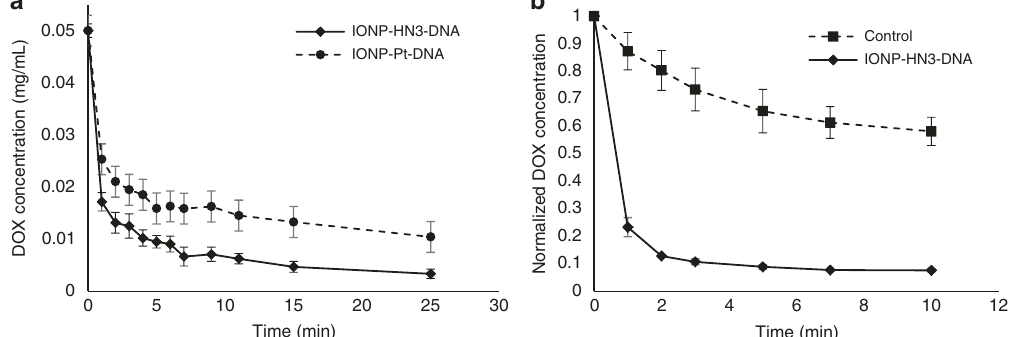
Fig. 2 DOX capture in human serum and porcine blood. a Decrease in DOX concentration in human serum, determined by fl uorescence, as a result of DOX capture by IONP-HN3-DNA and IONP-Pt-DNA; 100 ± 5 mg particle in 20 mL (0.05 mg/mL), 1 mg total DOX, 37 °C; error bars = 1 standard deviation ( n = 3). b Decrease in DOX plasma concentration as a result of DOX capture by IONP-HN3-DNA from porcine whole blood; 100 ± 5 mg IONP-HN3-DNA in 20 mL (0.05 mg/mL), 1 mg total DOX, 37 °C; error bars = 1 standard deviation ( n =